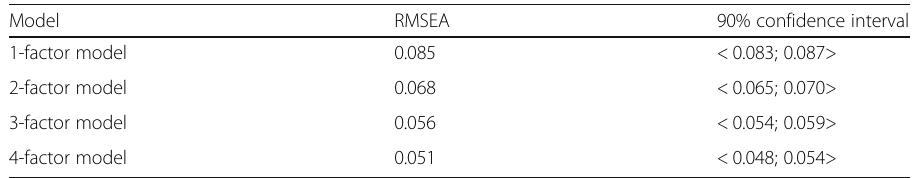
Table 4 Model fit for instrumental orientations